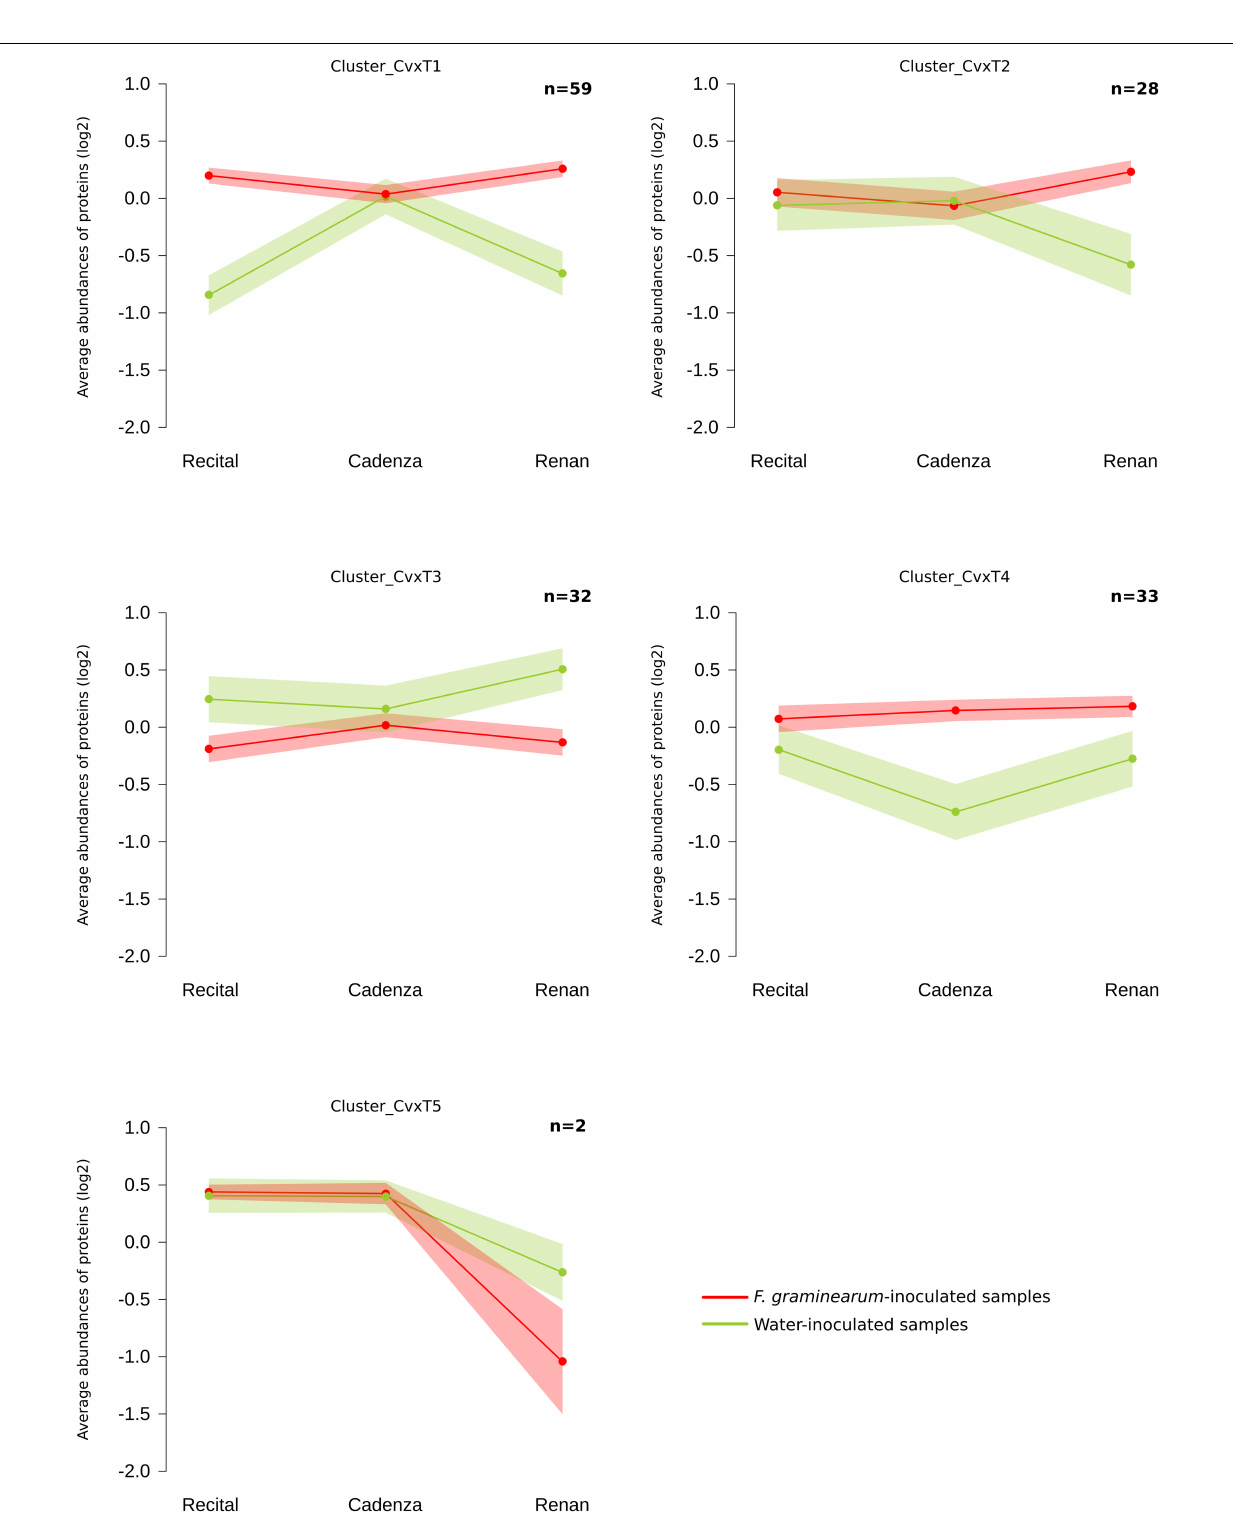
Frontiers in Plant Science |